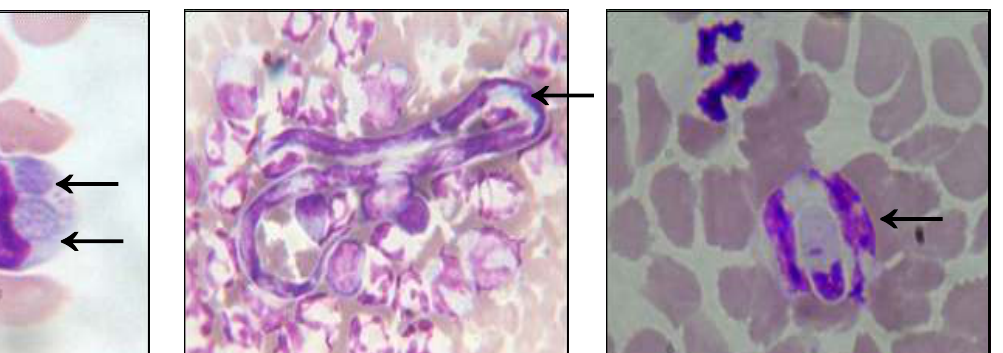
Figure-3. Ehrlichia ( Anaplasma ) platys inclusion in one out of three platelets